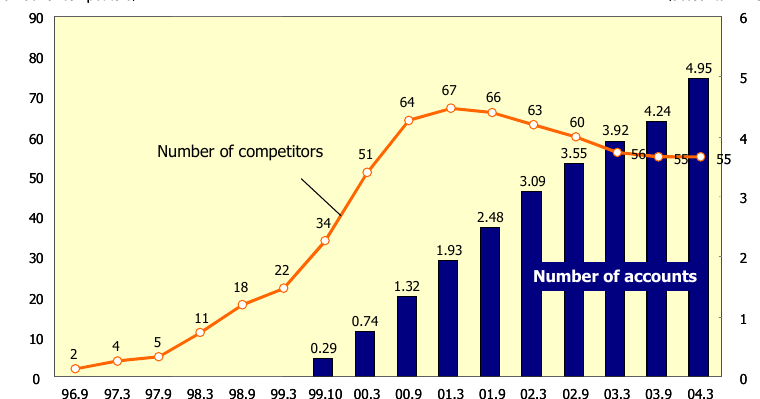
Figure 1. Number of competitors and total number of accounts (online